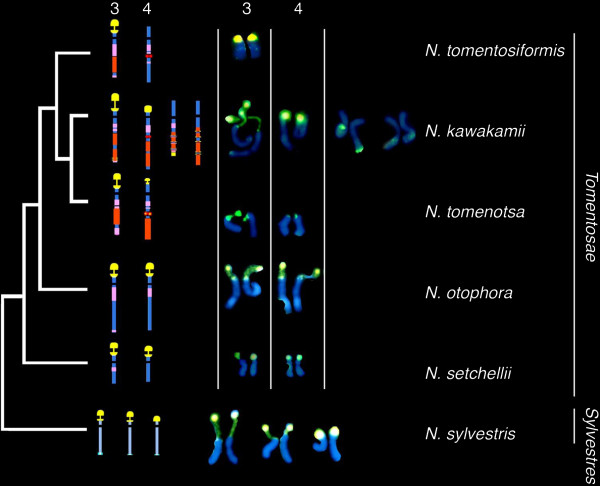
Phylogenetic relationships between species in section Tomentosae and N. sylvestris as determined by the distribution of repetitive DNA markers. 35S rDNA – yellow; tandem repeats: GRS –pink, NTRS - orange, GRD3 - red, GRD5 - red with yellow centre, HRS60 - blue and white (found only in N. sylvestris). Fluorescence in situ hybridisation of 35S rDNA on Nicotiana chromosomes (yellow signals) with chromosomes counterstained blue with DAPI. Note, dispersed yellow signals, particularly on the fourth pair of N. kawakamii chromosomes. Data and interpretative diagrams are taken from [17].